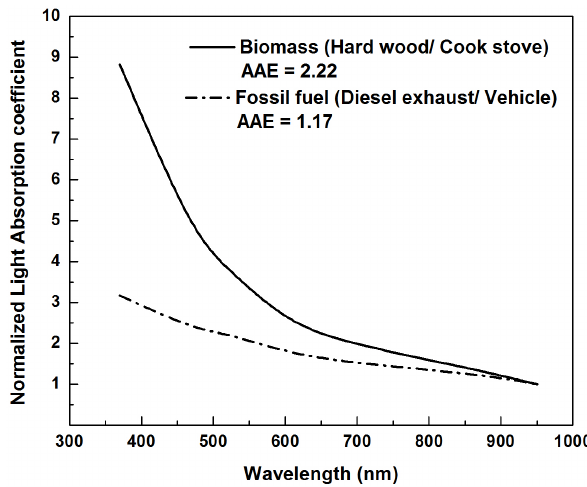
Fig. 2. Normalized light absorption coefficient of aerosol samples from biomass (hard wood in traditional mud cook stove) and fossil fuel (diesel) combustion measured using Aethalometer. AAE rep- resents the absorption angstrom exponent.